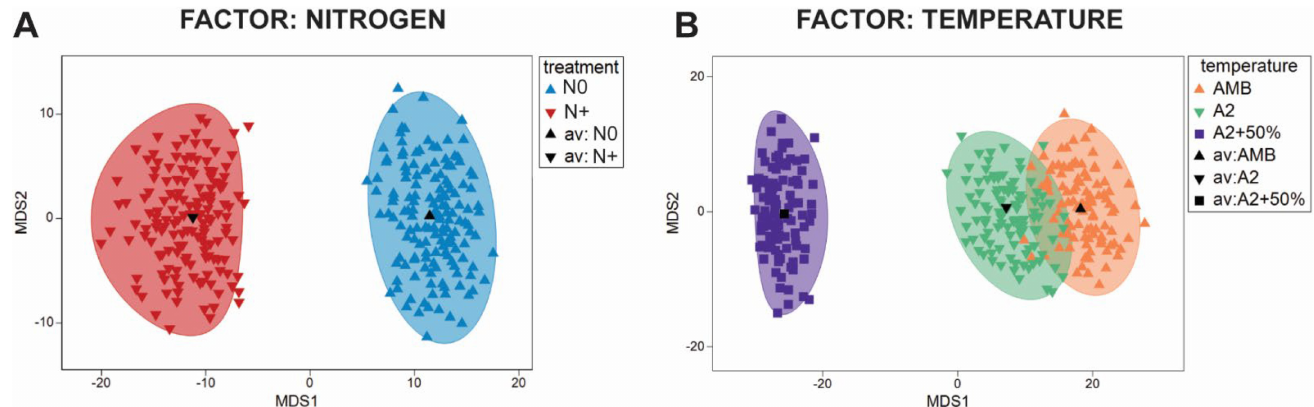
Figure 6. Bootstrap regions for phytoplankton community averages plotted in an mMDS plot with 150 bootstraps per group and 95% coverage. ( A ) Nitrogen treatment factor; ( B ) Temperature treatment factor.